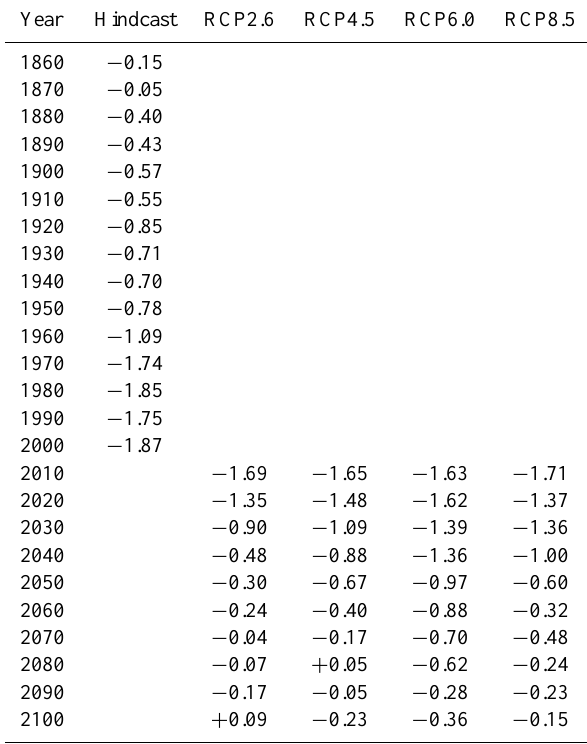
Table 2. Global mean adjusted forcing (in Wm − 2 ) due to the aerosol indirect effect at the tropopause in each decade (5-yr run- ning mean) relative to the preindustrial experiment simulated by